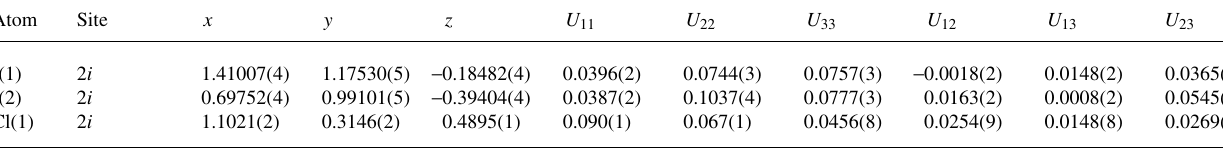
Table 3. Atomic coordinates and displacement parameters (in Å 2 ) .